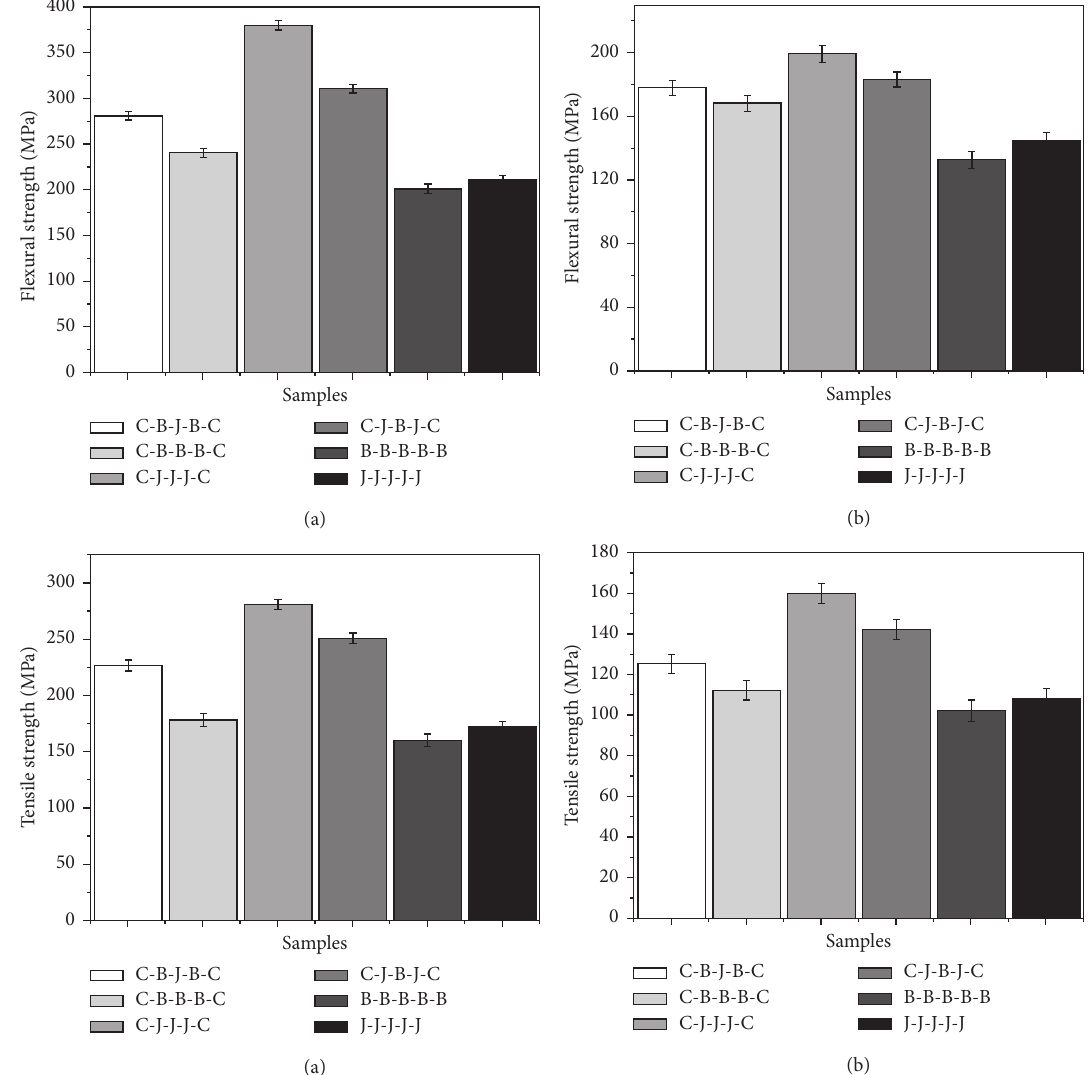
Figure 5: Flexural and tensile strength of (a) treated jute/banana/carbon fibre hybrid and (b) untreated jute/banana/carbon fibre hybrid composites [176].